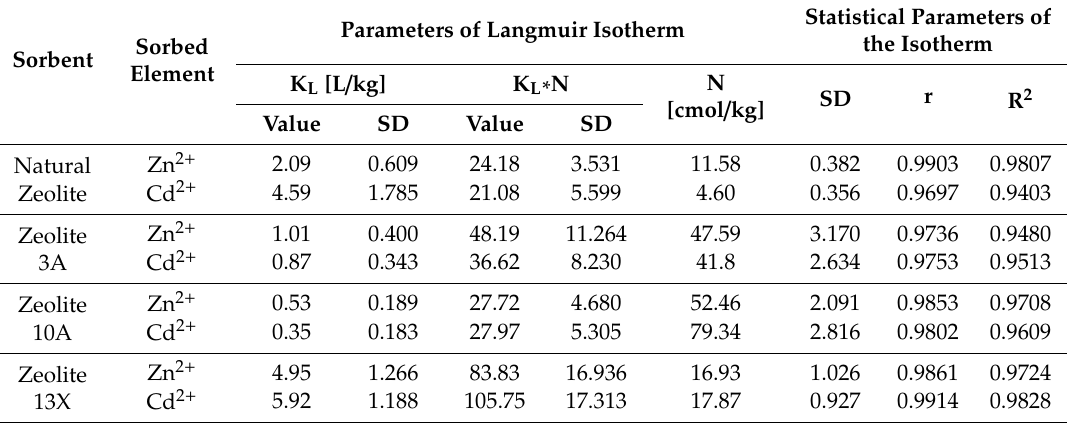
Parameters of Langmuir Isotherm